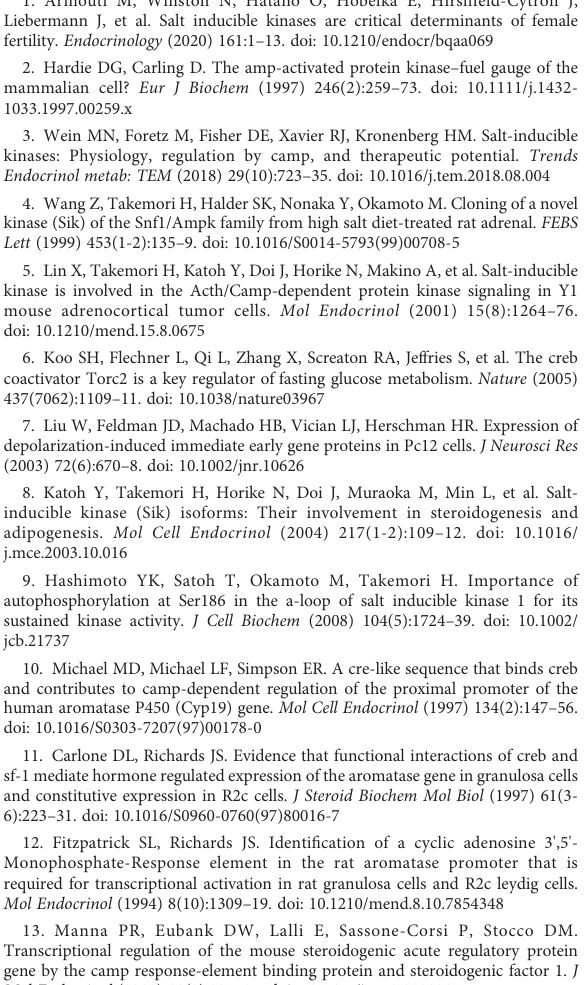
SUPPLEMENTARY FIGURE 2 Effect of SIK inhibition on FSH receptor expression. Rat GCs were treated with FSH in the presence or absence of HG. FSH receptor mRNA levels were measured 48 h after the initiation of treatments. No signi fi cant differences were found. One-way ANOVA followed by Tukey, n = 3.